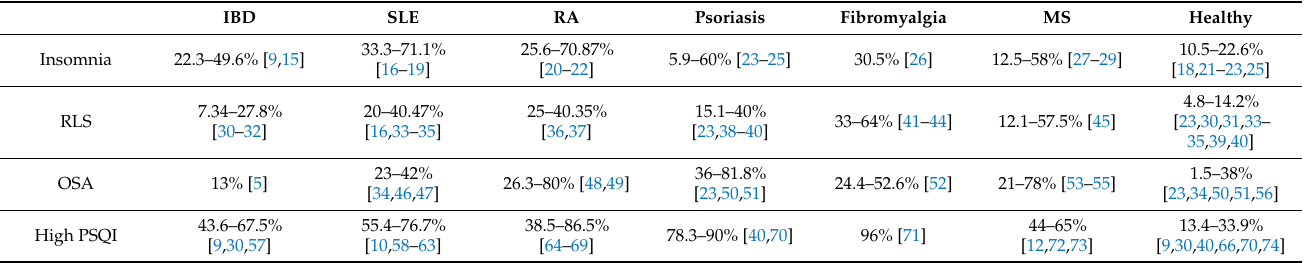
Table 1. Prevalence of sleep disturbances in people with immune-mediated diseases and the general